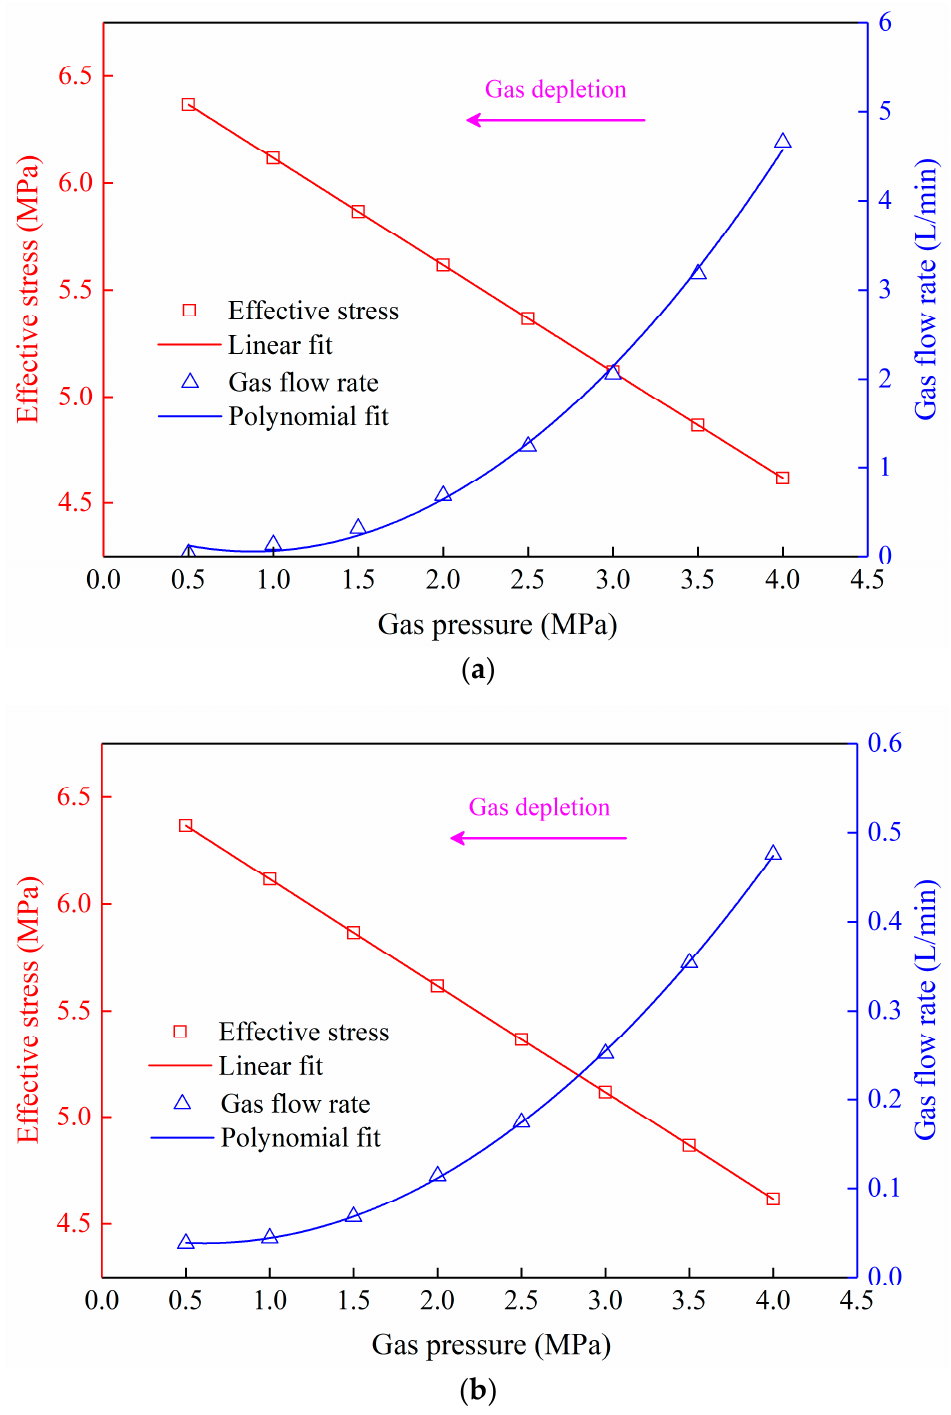
Figure 5. Effective stress-gas flow rate-gas pressure curves of coal during gas depletion. ( a ) tectonic coal; ( b ) intact coal.